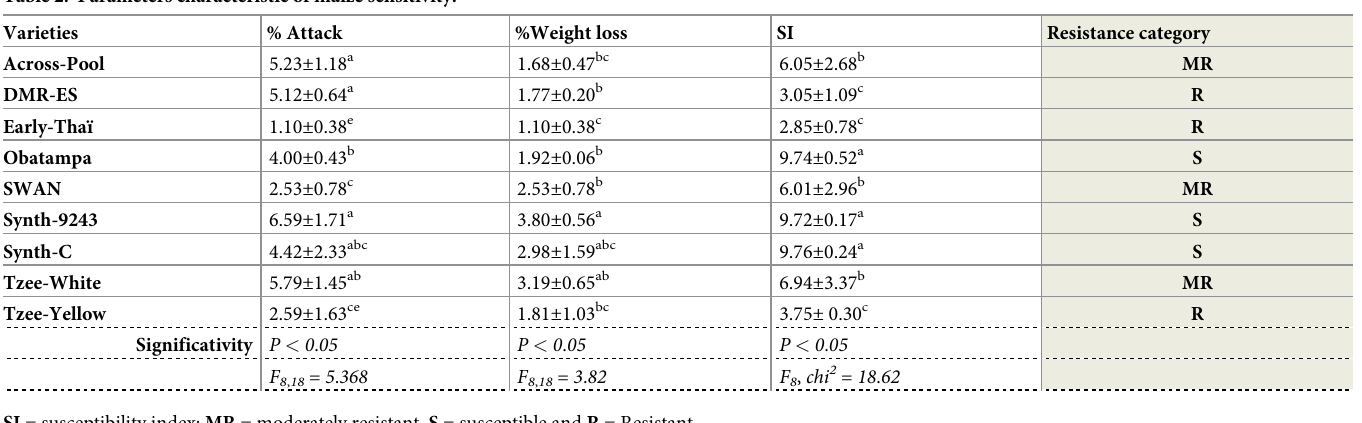
Table 3. There were significant differences among varieties for grain density (P = 0.031),